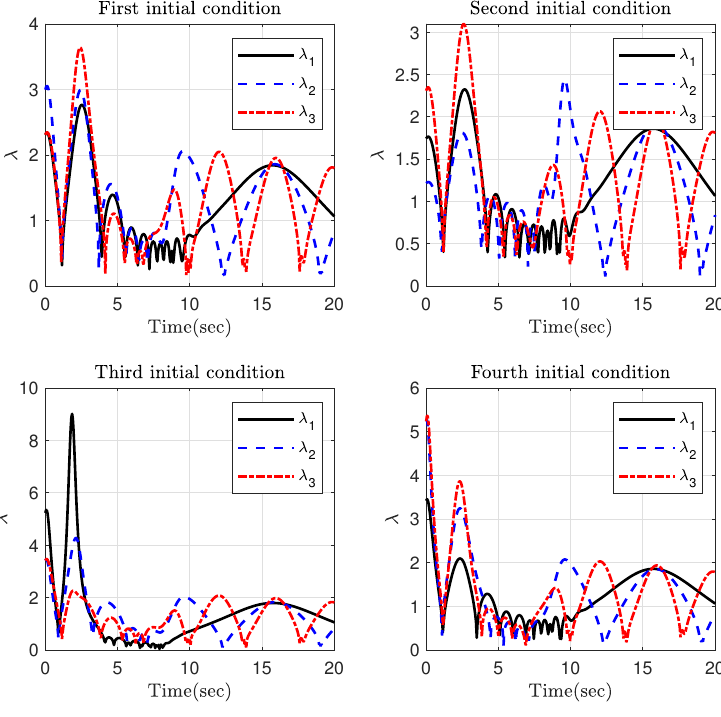
Figure 8. The parameter λ in Part 1 for different initial conditions.